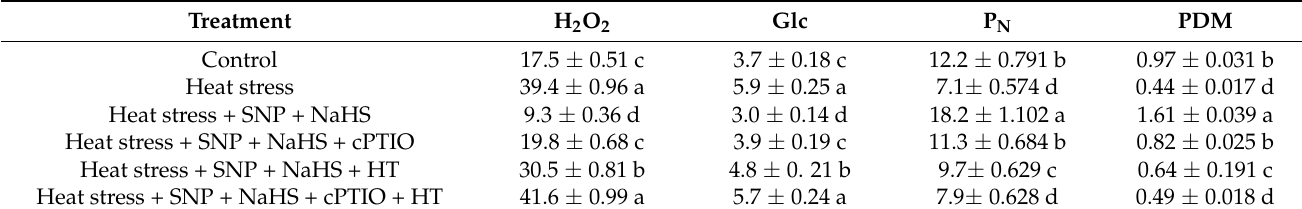
Table 1. H 2 O 2 content (nmol g − 1 FW), Glc (glucose content, mg g − 1 DW), P N (net photosynthesis, µ mol CO 2 m − 2 s − 1 ), and PDM (plant dry mass, g plant − 1 ) in leaves of wheat ( Triticum aestivum L. var. WH 542) plants treated with SNP (100 µ M) and/or NaHS (200 µ M) in the presence (40 ◦ C) or absence (25 ◦ C) of heat stress at 30 days after sowing (DAS). Data are presented as treatments mean ± SE ( n = 4). Data followed by same letter are not significantly different by LSD test at ( p < 0.05). cPTIO, 2-4-carboxyphenyl-4,4,5,5-tetramethylimidazoline-1-oxyl-3-oxide. DW, dry weight. H 2 O 2 , hydrogen